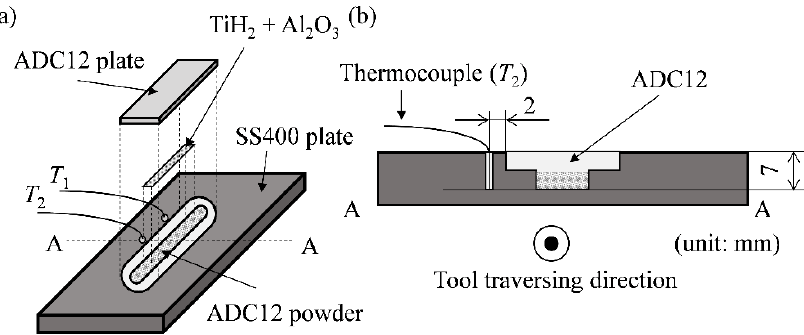
Figure 4. ( a ) Setup of powders and plate. ( b ) Cross section along A-A in ( a ).